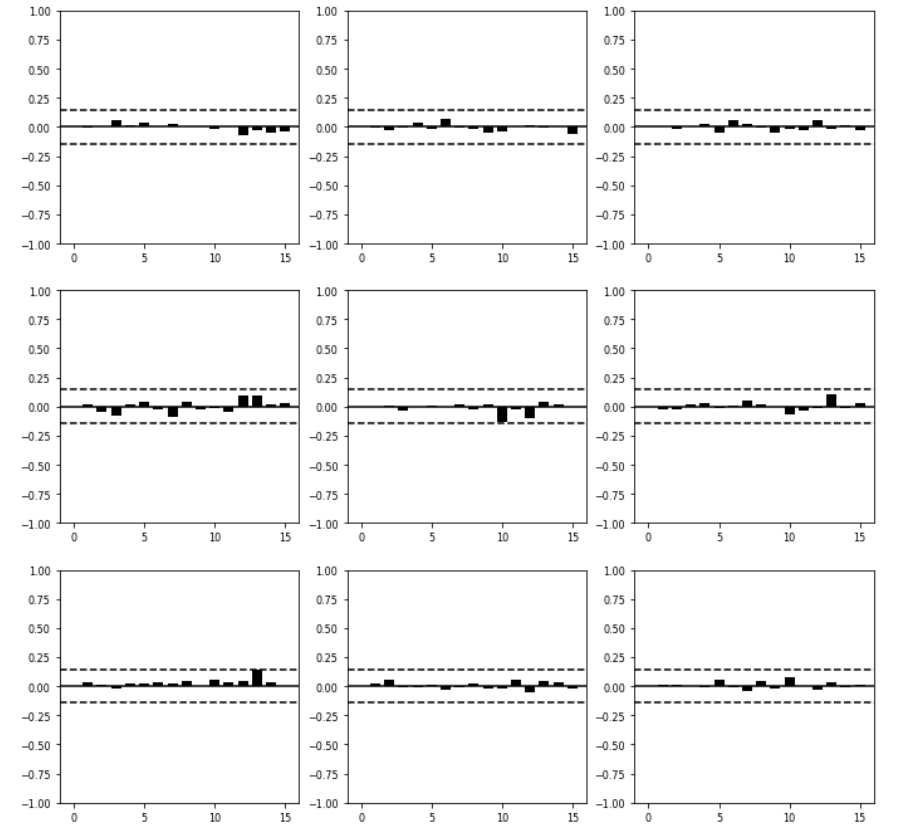
Figure A2. The autocorrelation plots from the